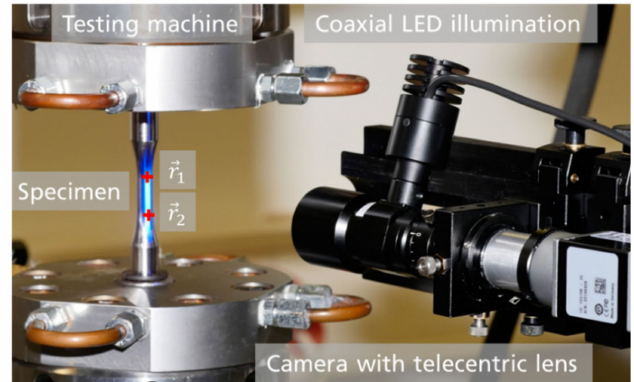
Figure 2. Image of the DIC measurement head and of a polished specimen in a servo-hydraulic testing machine. The red crosses mark the template positions